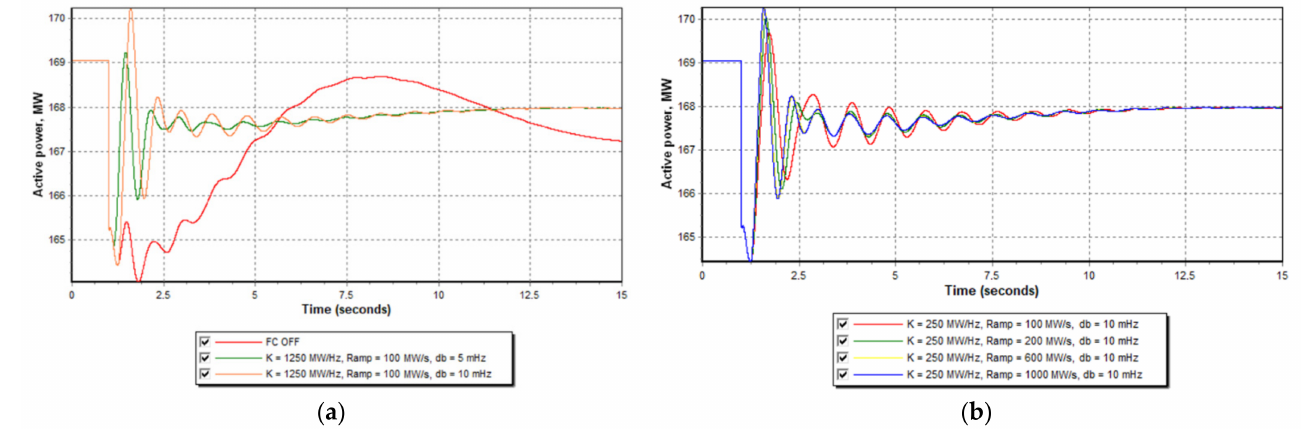
Figure 15. ( a ) Active power compensation of the thermal power plant at different FC parameters. ( b ) Active power compensation of the thermal power plant at different FC parameters.